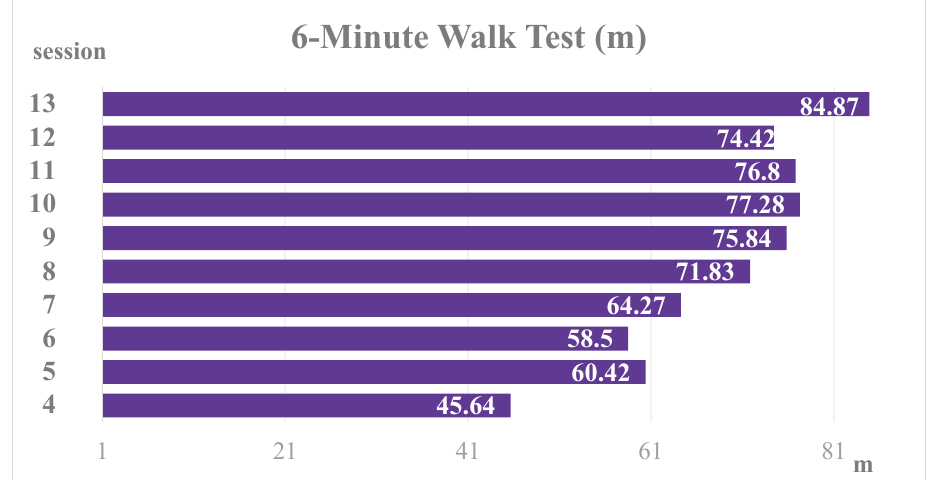
Figure 3. Trend of six MWT.